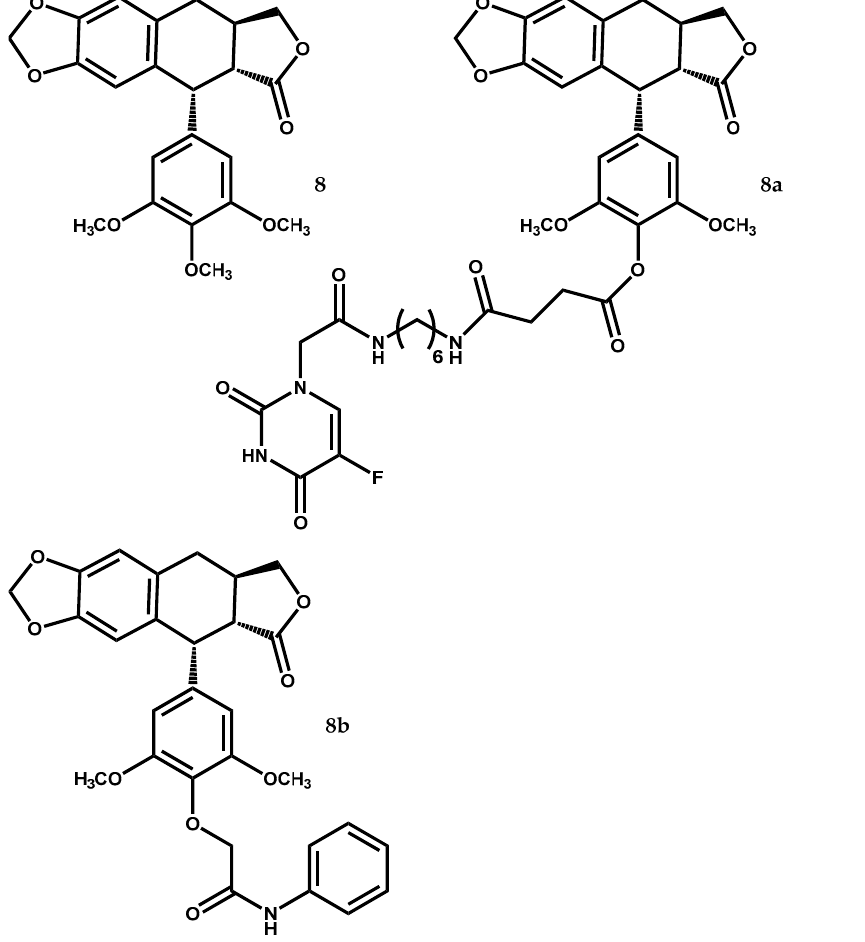
Figure 5. The bioactive lignan deoxypodophyllotoxin ( 8 ) identified in Juniperus species and its cytotoxic derivatives ( 8a ) and ( 8b ).